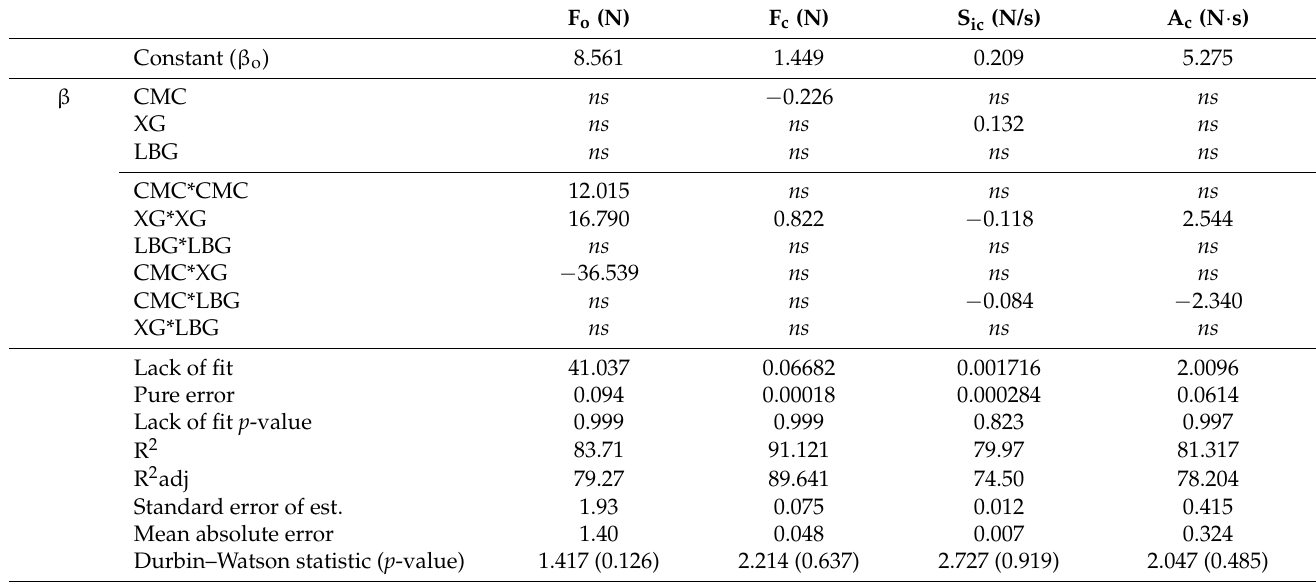
Table 5. Constant values ( β o ) and significant coefficients ( β ) at the 95% confidence interval of the stepwise multiple regression model for mechanical properties firmness (F), elasticity (Si), and consistency (A). F o (N) F c